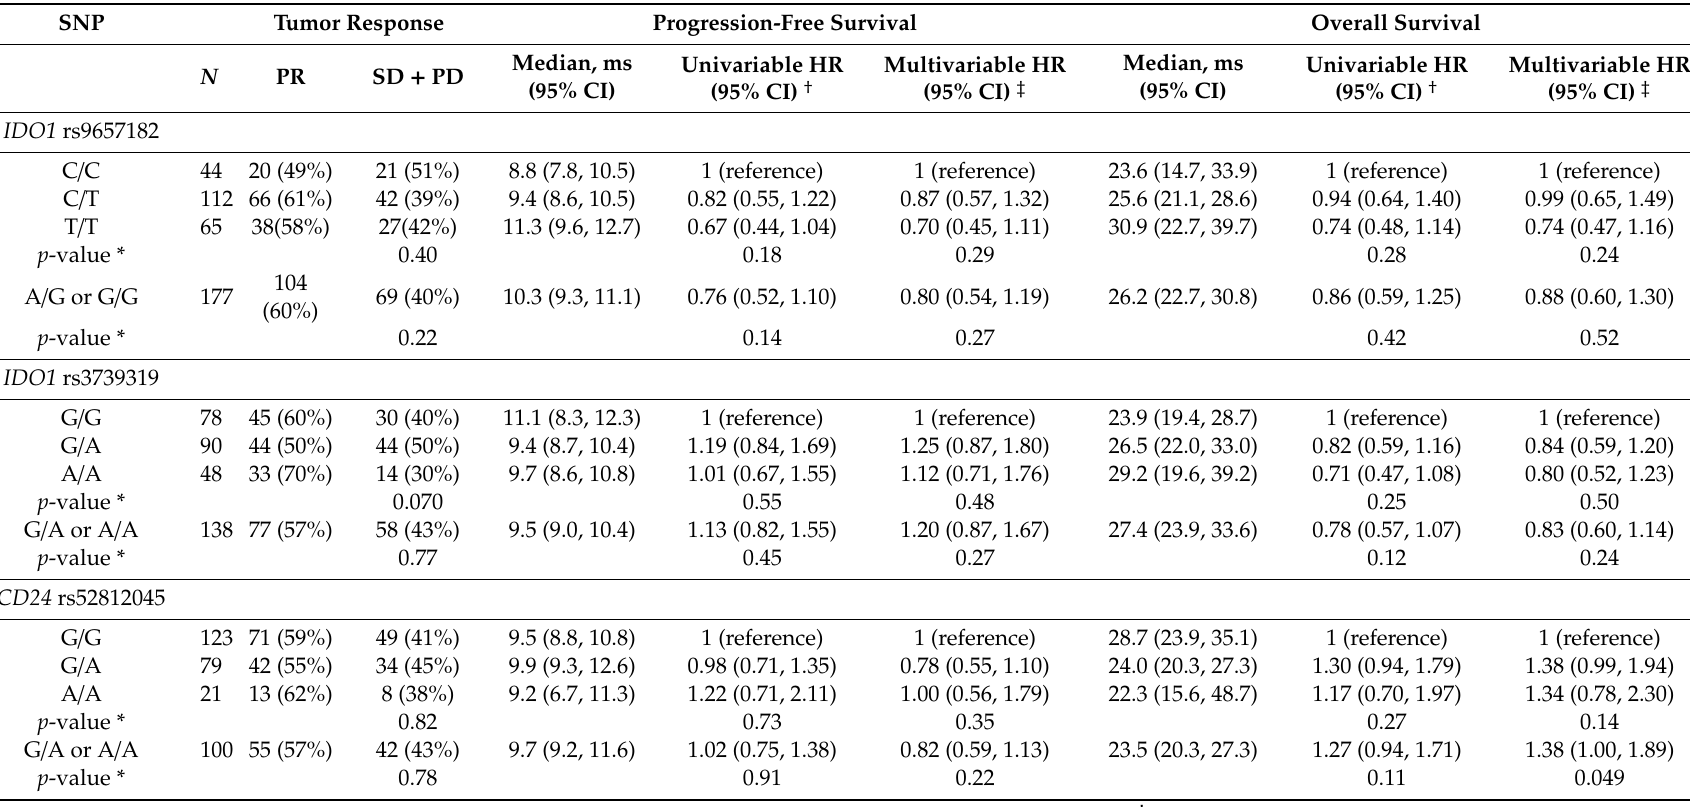
Table 6. Immune regulatory SNPs and outcomes in patients receiving first-line FOLFIRI and bevacizumab in TRIBE (control cohort